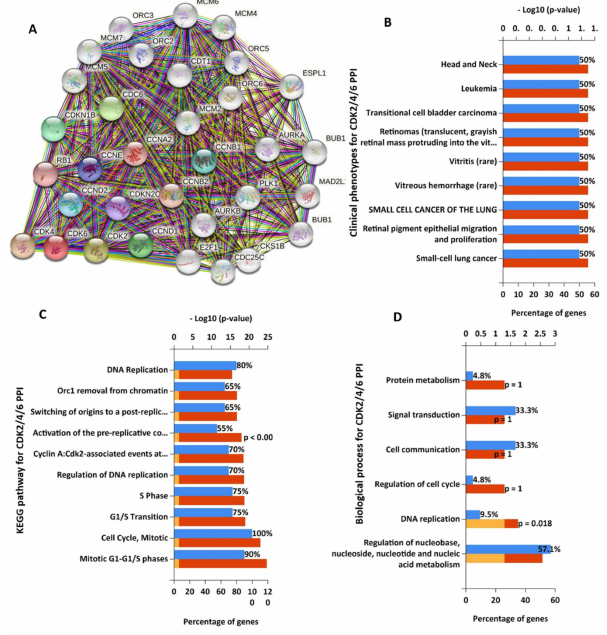
Figure 4. CDK2/4/6 clustering network revealed multiple interactions with oncogenic proteins. ( A ) The clustering network of CDK2/4/6 interactions generated a total of 33 nodes and 429 edges with an average local clustering coefficient of 0.877 and protein-protein interaction (PPI) enrich- ment p -value of <10 − 16 . Enriched ( B ) clinical phenotypes, ( C ) KEGG pathways, and ( D ) biological processes for CDK2/4/6 clustering